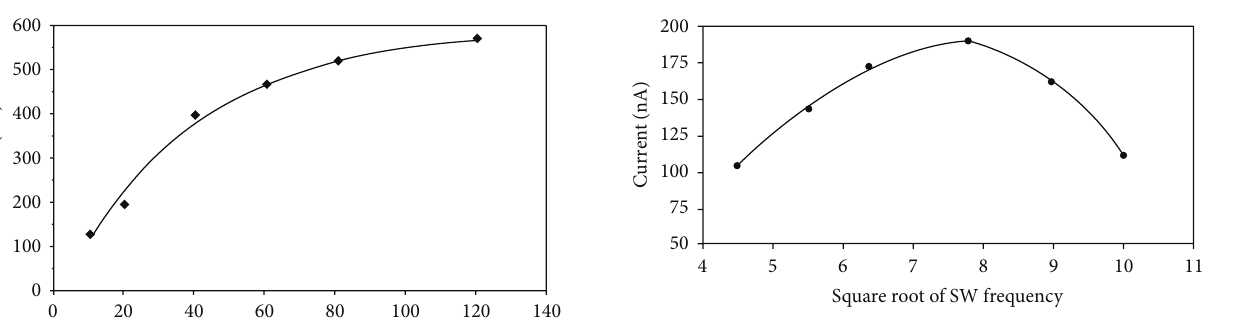
Figure 7: The effect of the square root of the SW frequency on the current of the square-wave stripping peak for Ni(II)-salen. Other conditions as in Figure